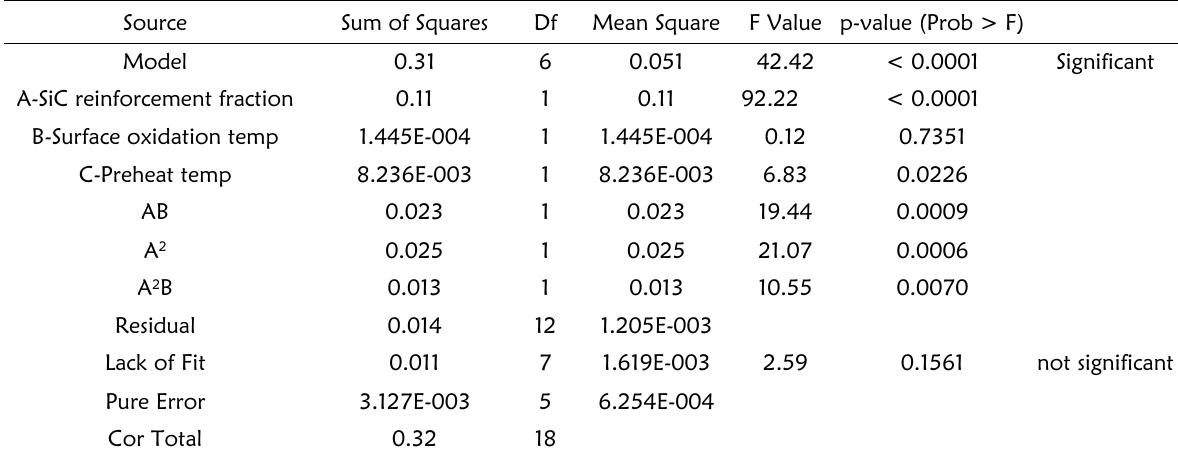
Table 8: Analysis of variance for coefficient of friction